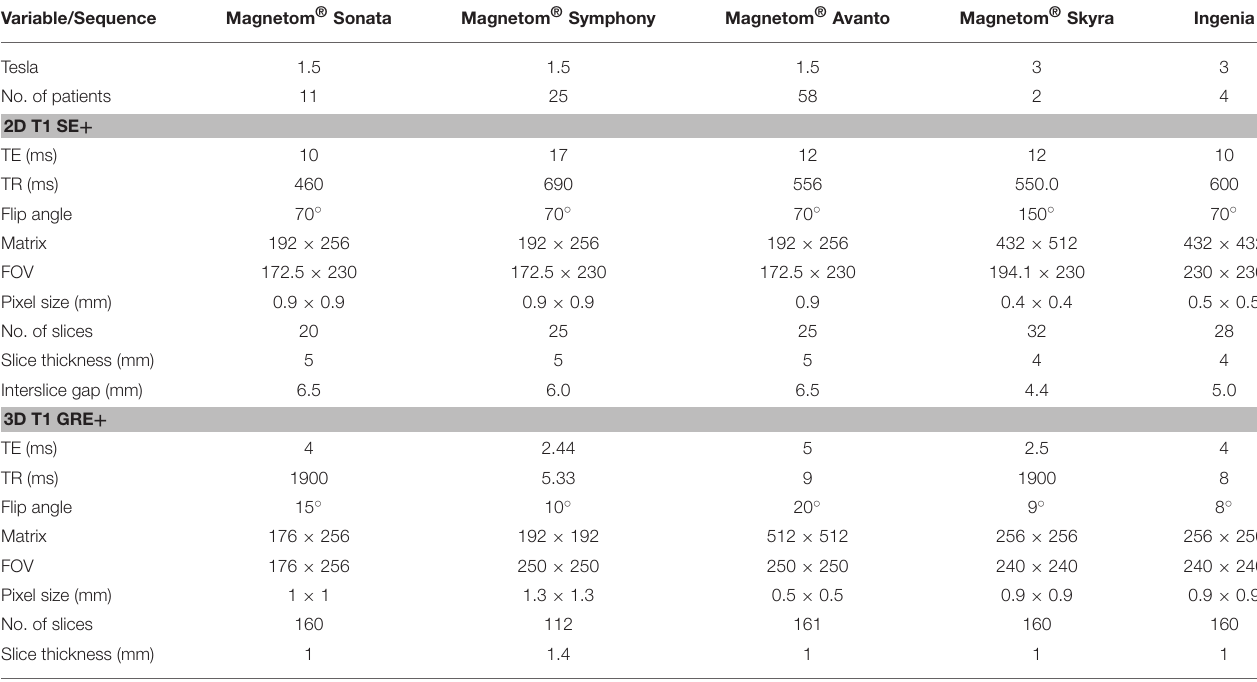
TABLE 1 | Sequence parameters of the axial post-contrast T1w spin echo with flow compensation (2D T1 SE + ) and/or three-dimensional T1w gradient echo sequence (3D T1 GRE + ) of different MRI scanners.